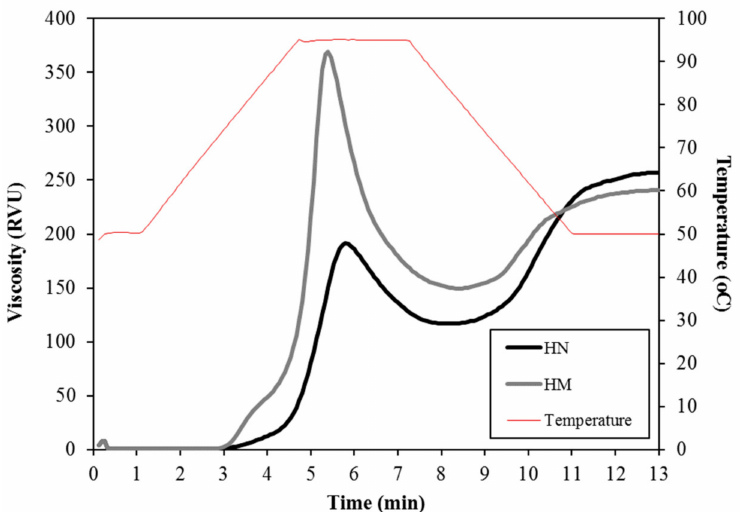
Figure 5. The mean pasting pattern of Hom Nil rice flour (HN) and Hom Mali 105 rice flour (HM). Table 2. Pasting properties of Hom Nil rice flour (HN) and Hom Mali 105 rice flour (HM). Rice Cultivar